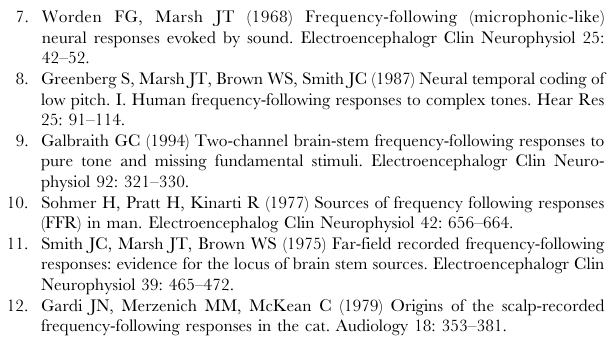
Figure S1 Mean evoked potential responses to stimuli. (a) The five different tone complexes used are shown color-coded above their constituent components on an amplitude - frequency plot (bottom), where the components of each tone are overlaid on a common set of axes. (b,c) Mean relative amplitude spectra (22 participants) for the 0 u (in b) and 180 u (in c) responses, showing the similarity in the response patterns evoked by these stimulus classes. Responses to each stimulus tone have been overlaid on the same set of axes. Colors refer to part (a) of the figure. (d,e) Mean relative amplitude spectra (n= 22 participants) of peaks in the fine- structure-related (difference waveform, d) and envelope-related (sum waveform, e) evoked potential responses. Responses to each stimulus tone have been overlaid on the same set of axes. Colors refer to part (a) of the